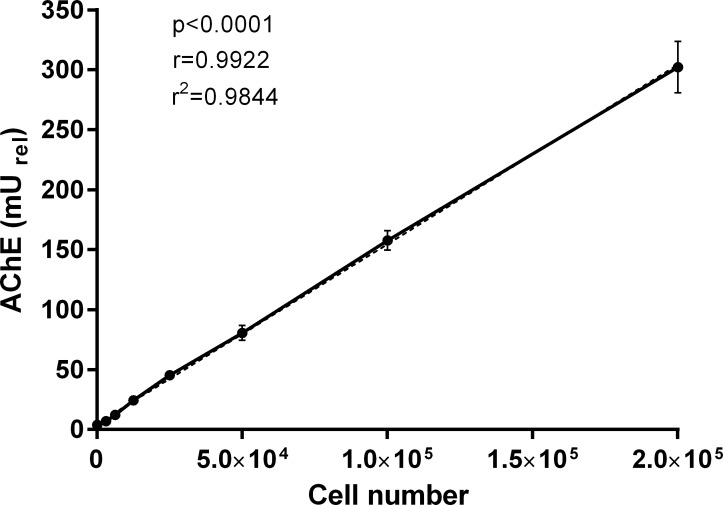
Correlation of AChE activity with cell number.Data presented as mean ± SEM of three individual experiments. Coefficient of determination (r2), correlation coefficient (r) and p-value (p) was calculated by Pearson linear regression analysis.